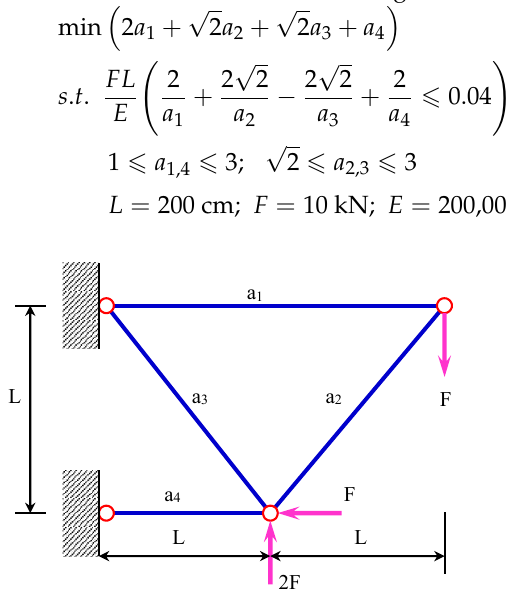
Figure A1. Four-bar truss. Two-bar truss